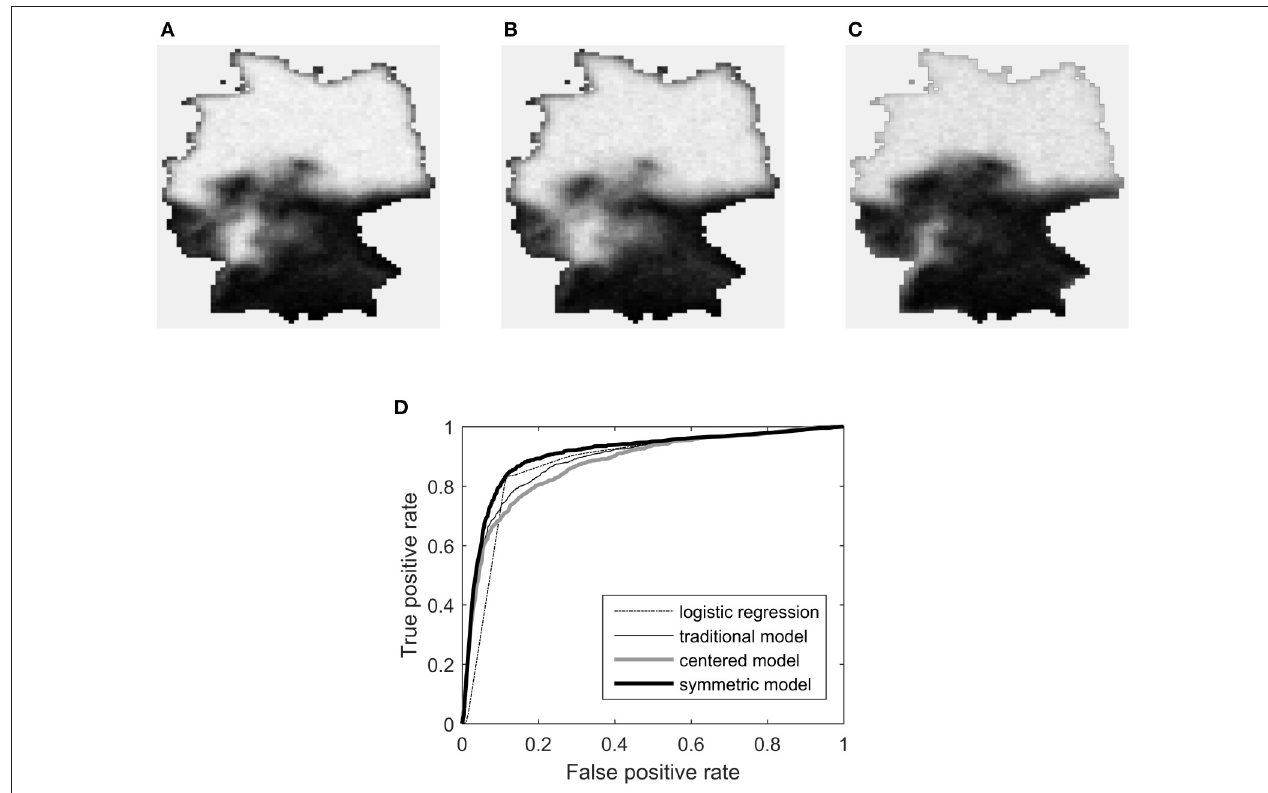
FIGURE 11 | Results of ALR analysis of the H. vulgaris data. The top row shows marginal probability maps for (A) the traditional S 0,1 model, (B) the centered model, and (C) the symmetric model. Plot (D) gives the receiver operating characteristic curves for the three models as well as ordinary logistic regression.